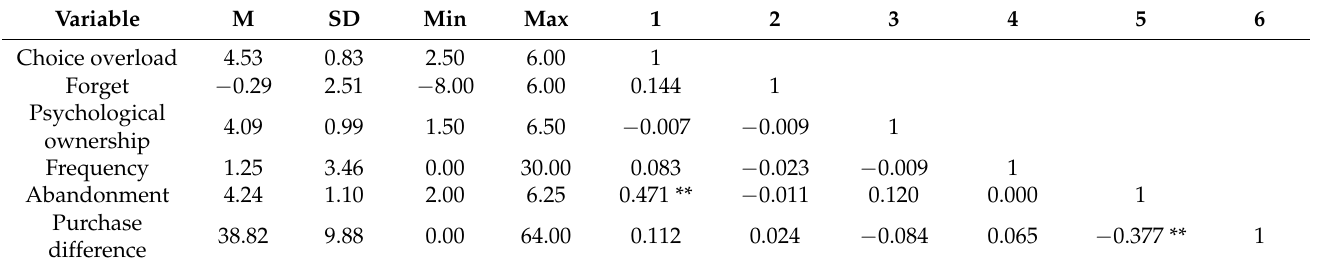
Table 6. Descriptive statistics and variable correlation.